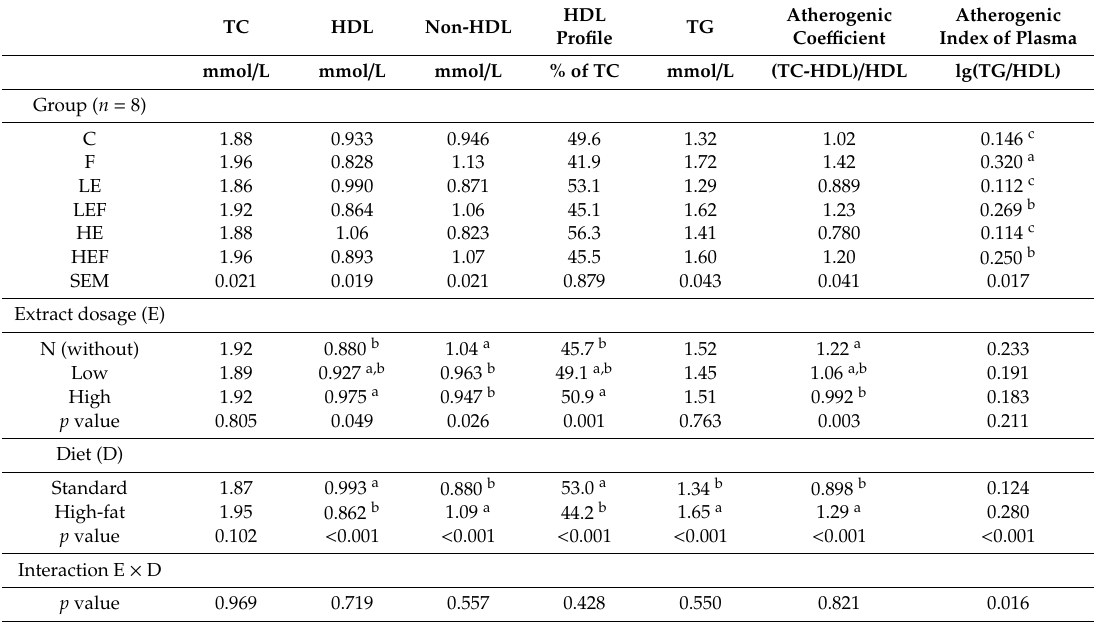
Atherogenic Atherogenic HDL TG Profile Coe ffi cient Index of Plasma